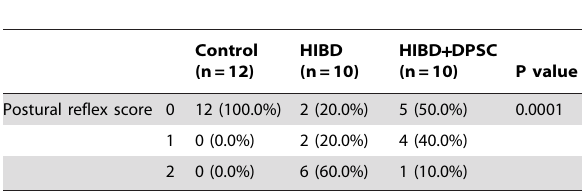
Table 2. Postural Reflex Scores Among the 3 Groups is This